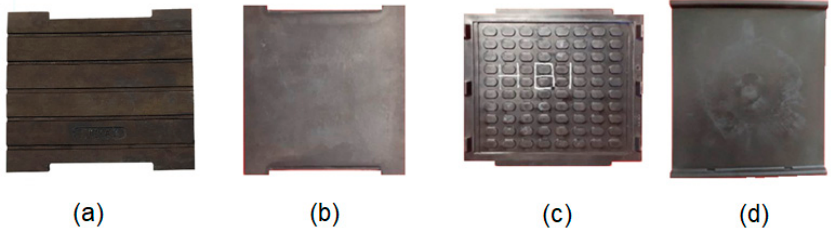
Figure 2. Rail pads: ( a ) rubber rail pad [4]; ( b ) EPDM rail pad; ( c ) TPE rail pad; ( d ) EVA rail pad; ( b ), ( c , d ) based on [3]. ( b – d ) based on